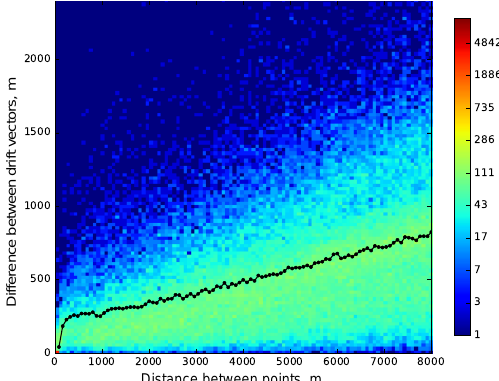
Figure 11. Sea ice drift anomaly (compared to mean drift of the scene) detected in a 300 × 400 pix (24 × 32km) sub-image from Fram Strait (Table 1) close to the marginal ice zone.